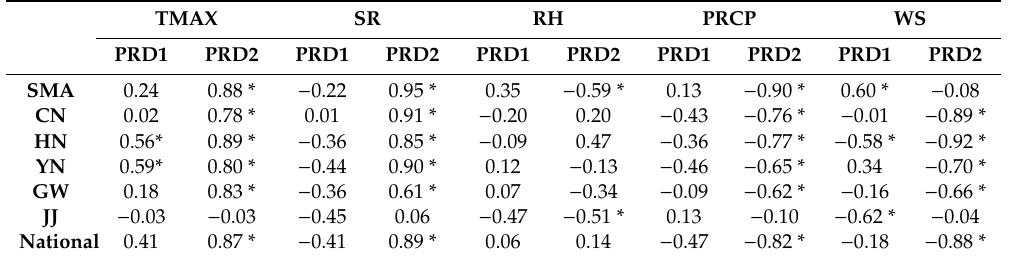
Figure 7. Correlation coefficient differences between PRD1 and PRD2 (PRD2–PRD1) in air quality regions for the O 3 –meteorological factors relationship. Table 4. Annual correlation coe ffi cients between O 3 and meteorological factors in di ff erent air quality regions (Seoul Metropolitan Area, SMA; Central region, CN; Honam, HN; Yeongnam, YN; Gangwon, GW; Jeju, JJ) and di ff erent periods (statistically significant R values in the 95% confidence interval of the Pearson’s correlation coe ffi cient are marked with